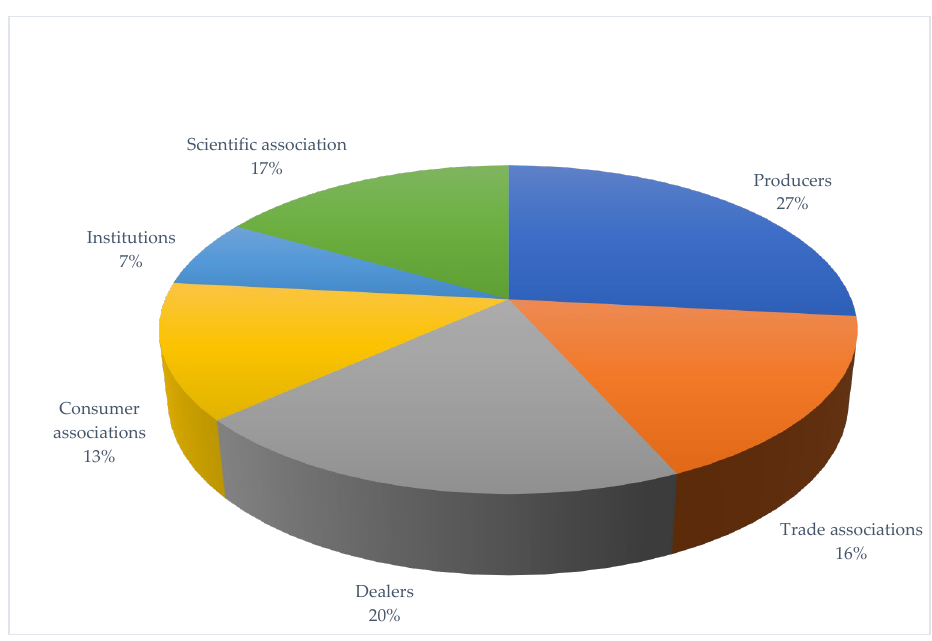
Figure 2. Categories of stakeholders who participated in the assessment survey on agrifood readiness for digital transformation